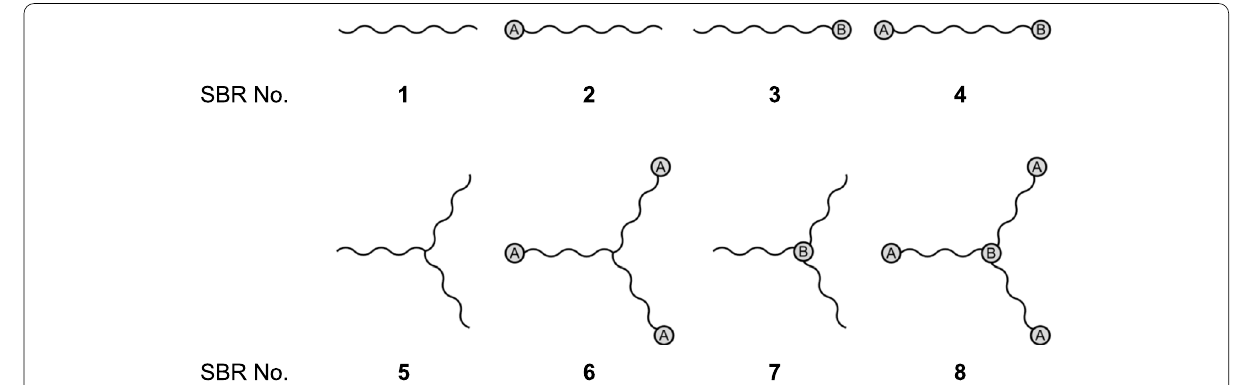
Fig. 1 Structure of SBR, A Amine group which can interact with silica and creates ionic or hydrogen bond, B Functional group described in Fig.